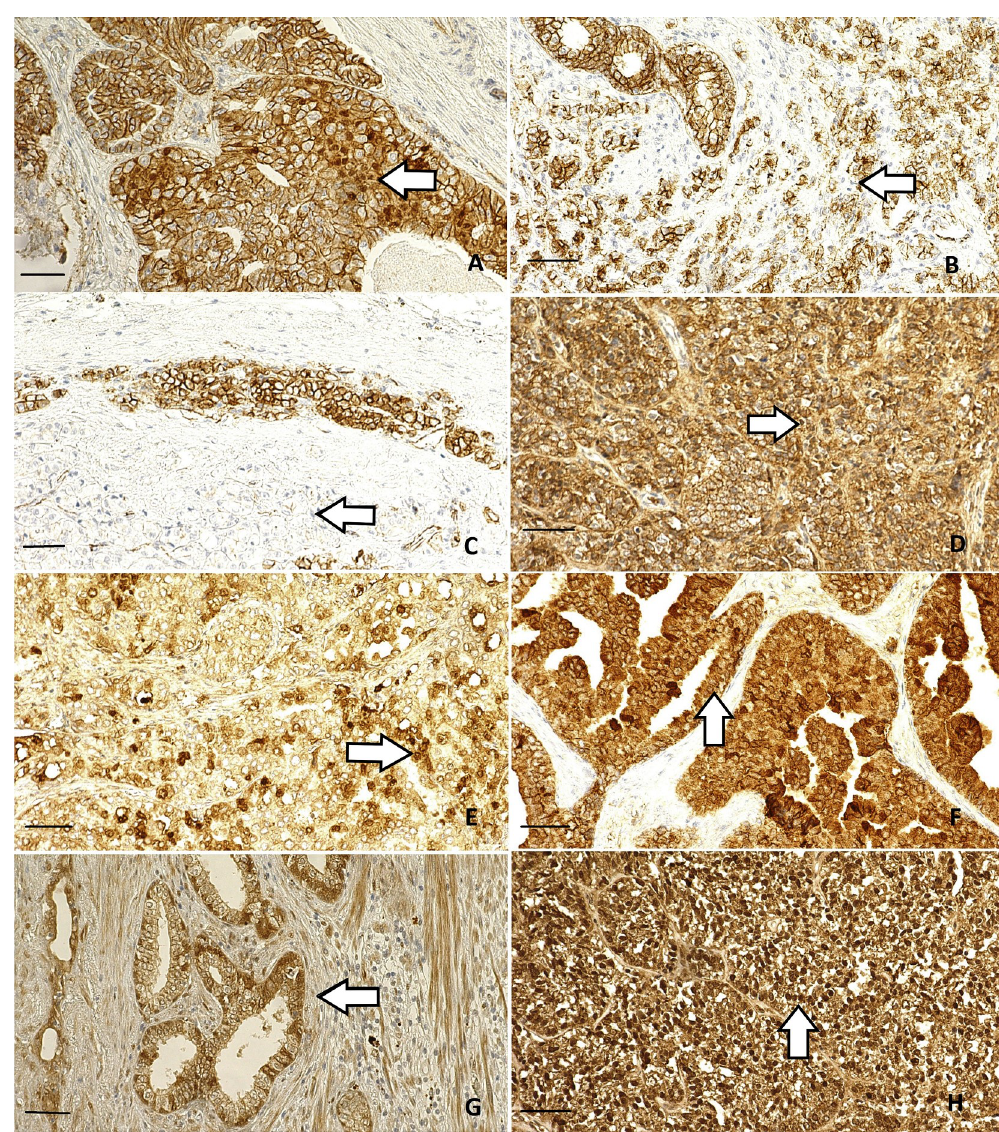
Fig 1. Microphotograph presenting the EMT-related proteins expression in prostate cancer tissue. Representative immunohistochemistry images presenting EMT-related proteins in TMA sections of prostate cancer tissue. A-white arrow demonstrates membrane and nuclear β -catenin expression; B-white arrow demonstrates partially reduced membrane β - catenin expression; C-white arrow demonstrates completely reduced membrane β -catenin expression; D-white arrow demonstrates completely reduced membrane E-cadherin expression; E-white arrow demonstrates the nuclear E-cadherin expression; F-white arrow demonstrates the cytoplasmic E-cadherin expression; G-white arrow demonstrates the nuclear SOX-4 expression; H-white arrow demonstrates the nuclear MIF expression. Original magnification was x10 for A-H figures. Nucleus counterstained with hematoxylin. Scale bar: 100 μ m.